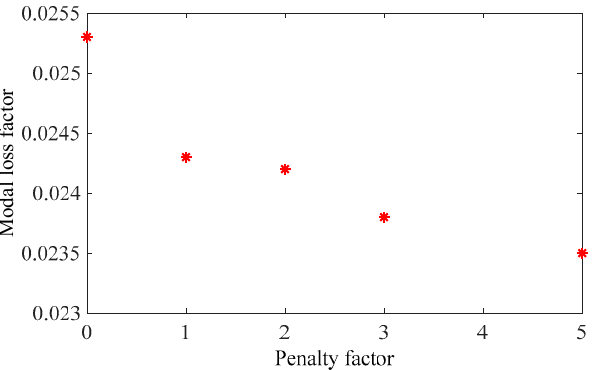
Figure 9. The first modal loss factor of the optimization results obtained by varying the penalty factor.